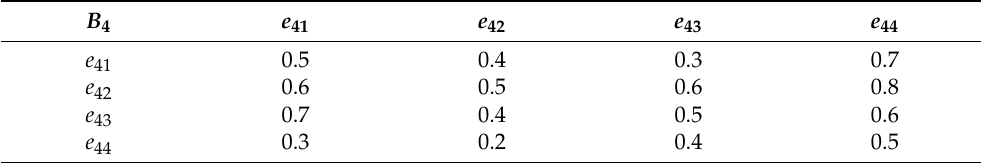
Table A21. Fuzzy symmetric matrix for inducing factors B 4 .